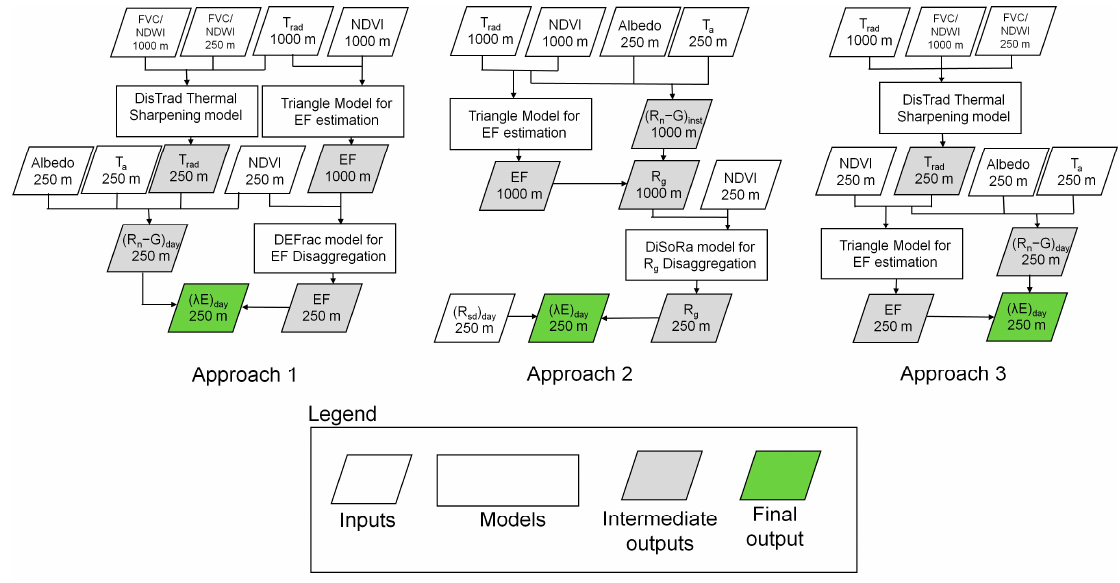
Figure 2. Flowchart indicating the steps involved in estimating λ E day at 250 m using the three approaches.